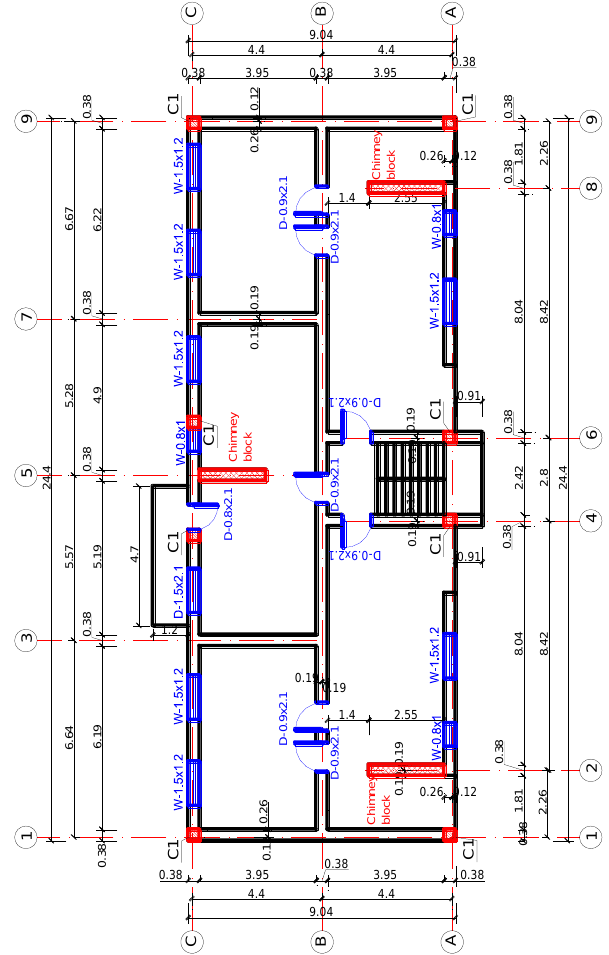
Figure 1. Template design 83/3, (National Archive of Albania, 1983) Fig. 1. Template design 83/3, (National Archive of Albania, 1983).